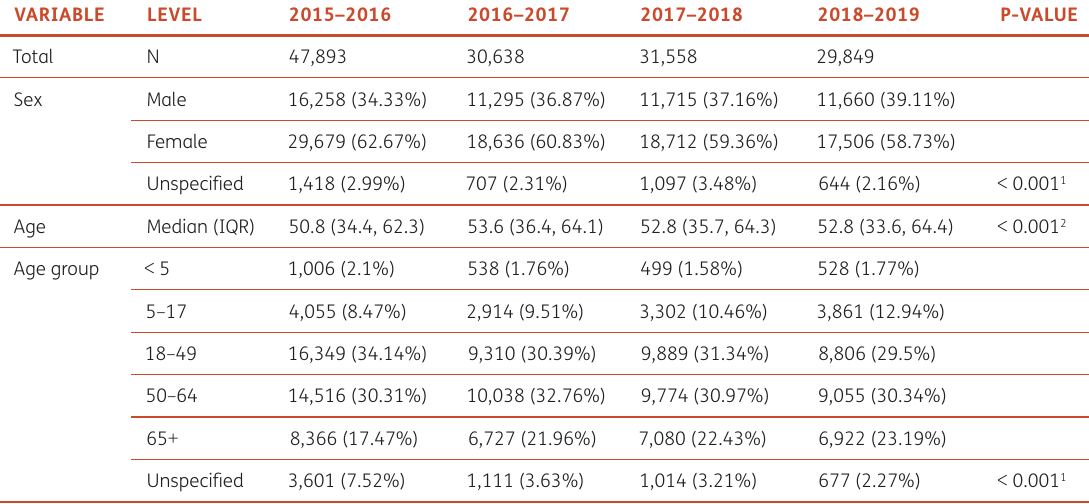
Table 2 Descriptive statistics of registered Flu Near You (FNY) participant demographics for the 2015–2016, 2016–2017, 2017–2018, and 2018–2019 seasons. Continuous variables are displayed as median (25 th quartile, 75 th quartile), and categorical variables are displayed as n